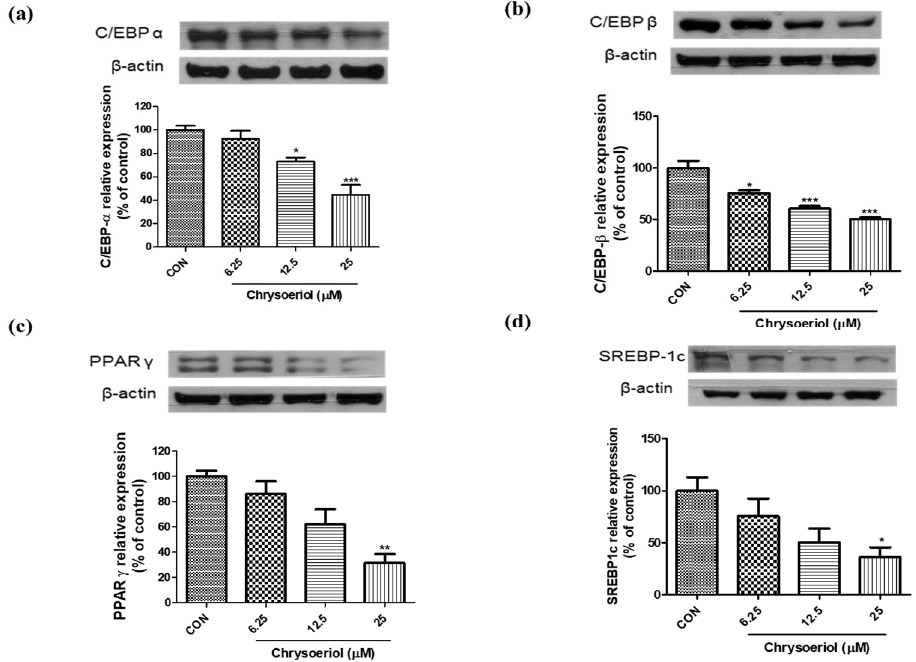
Figure 3. Effects of chrysoeriol on CEBP- α ( a ), C/EBP- β ( b ), SREBP1c ( c ) and PPAR γ ( d ) expression in 3T3-L1 adipocytes. *, **, *** p < 0.05, 0.01, and 0.001, respectively, significant difference compared with control group. CON, control (differentiated